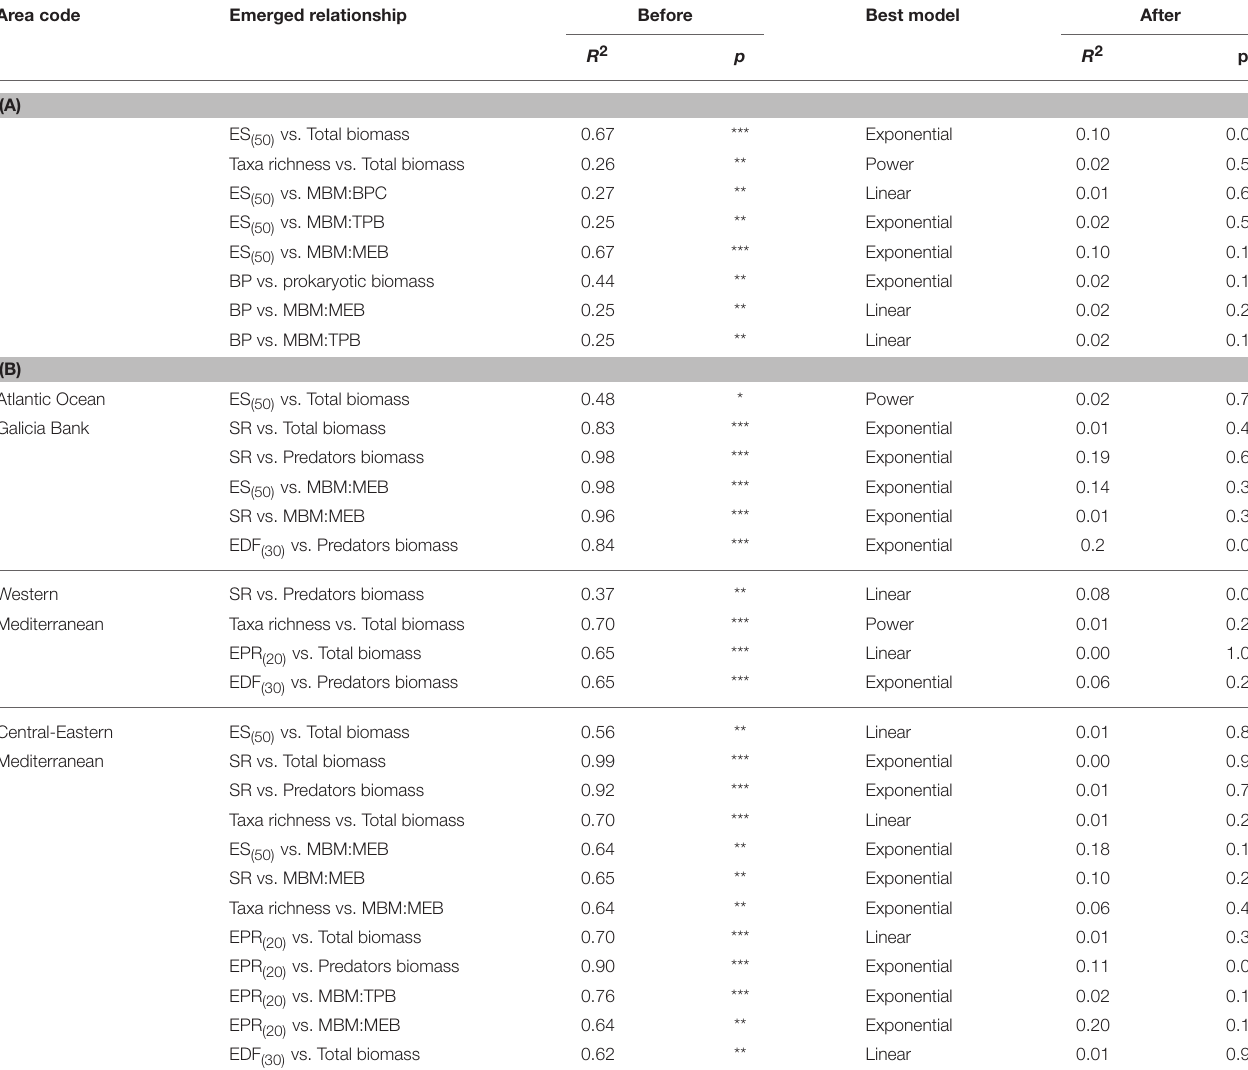
TABLE 4 | Biodiversity and functional diversity effects on ecosystem functioning and efficiency, before and after covariables removal, at (A) large spatial scale and (B) basin- spatial scale. Area code Emerged relationship Before Best model